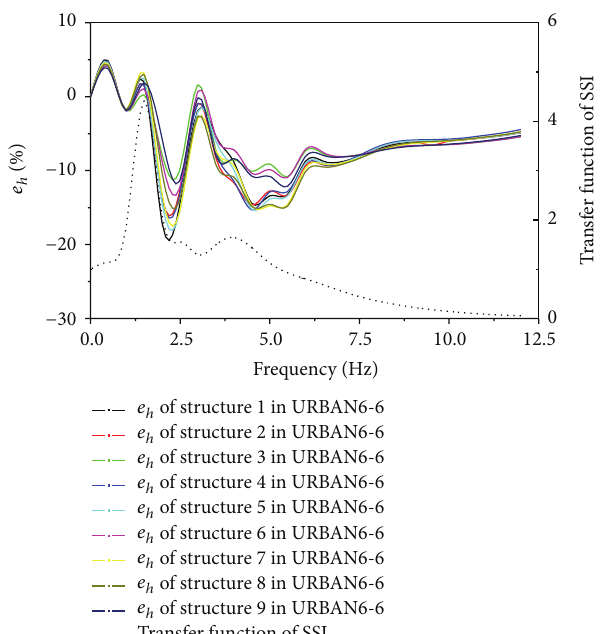
Figure 6: Interaction among structures in terms of influence coefficient 𝑒 ℎ (URBAN6-6, 𝑆𝑋 , 𝐷 = 0.5 ). The solid lines are the influence coefficient 𝑒 ℎ of URBAN6-6 system. The dashed line is the transfer function 𝑄 in the URBAN1-1 (SSI) system.